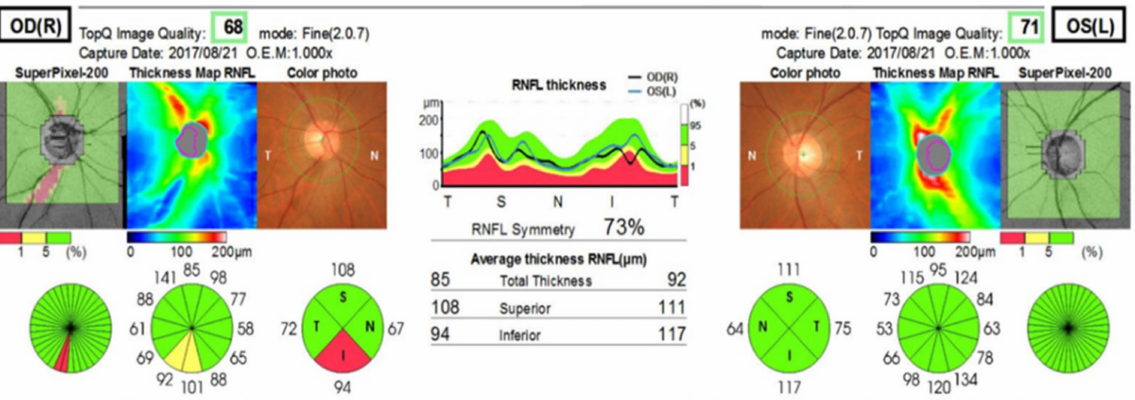
Figure 4. RNFL thickness: Swept Source OCT (Triton [TOPCON]). OCT indicates thinning of the nerve fiber layer in the right